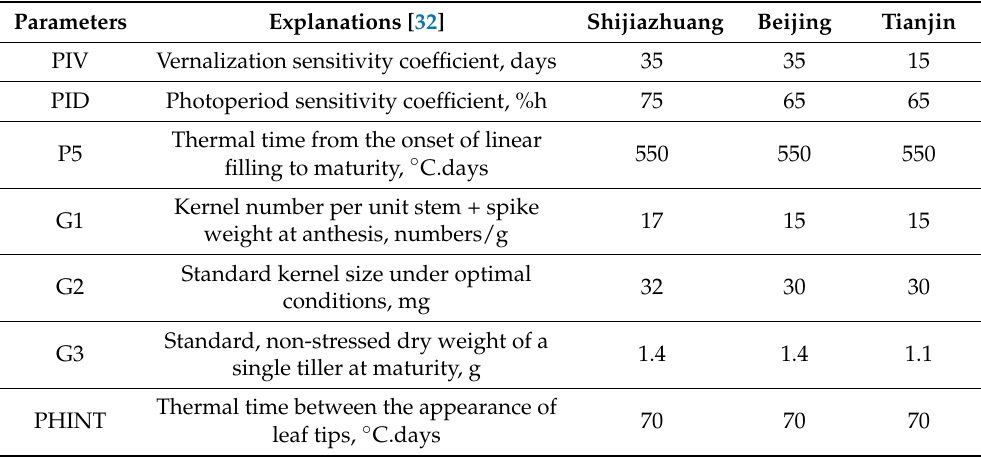
Table 2. The variety parameters of winter wheat.